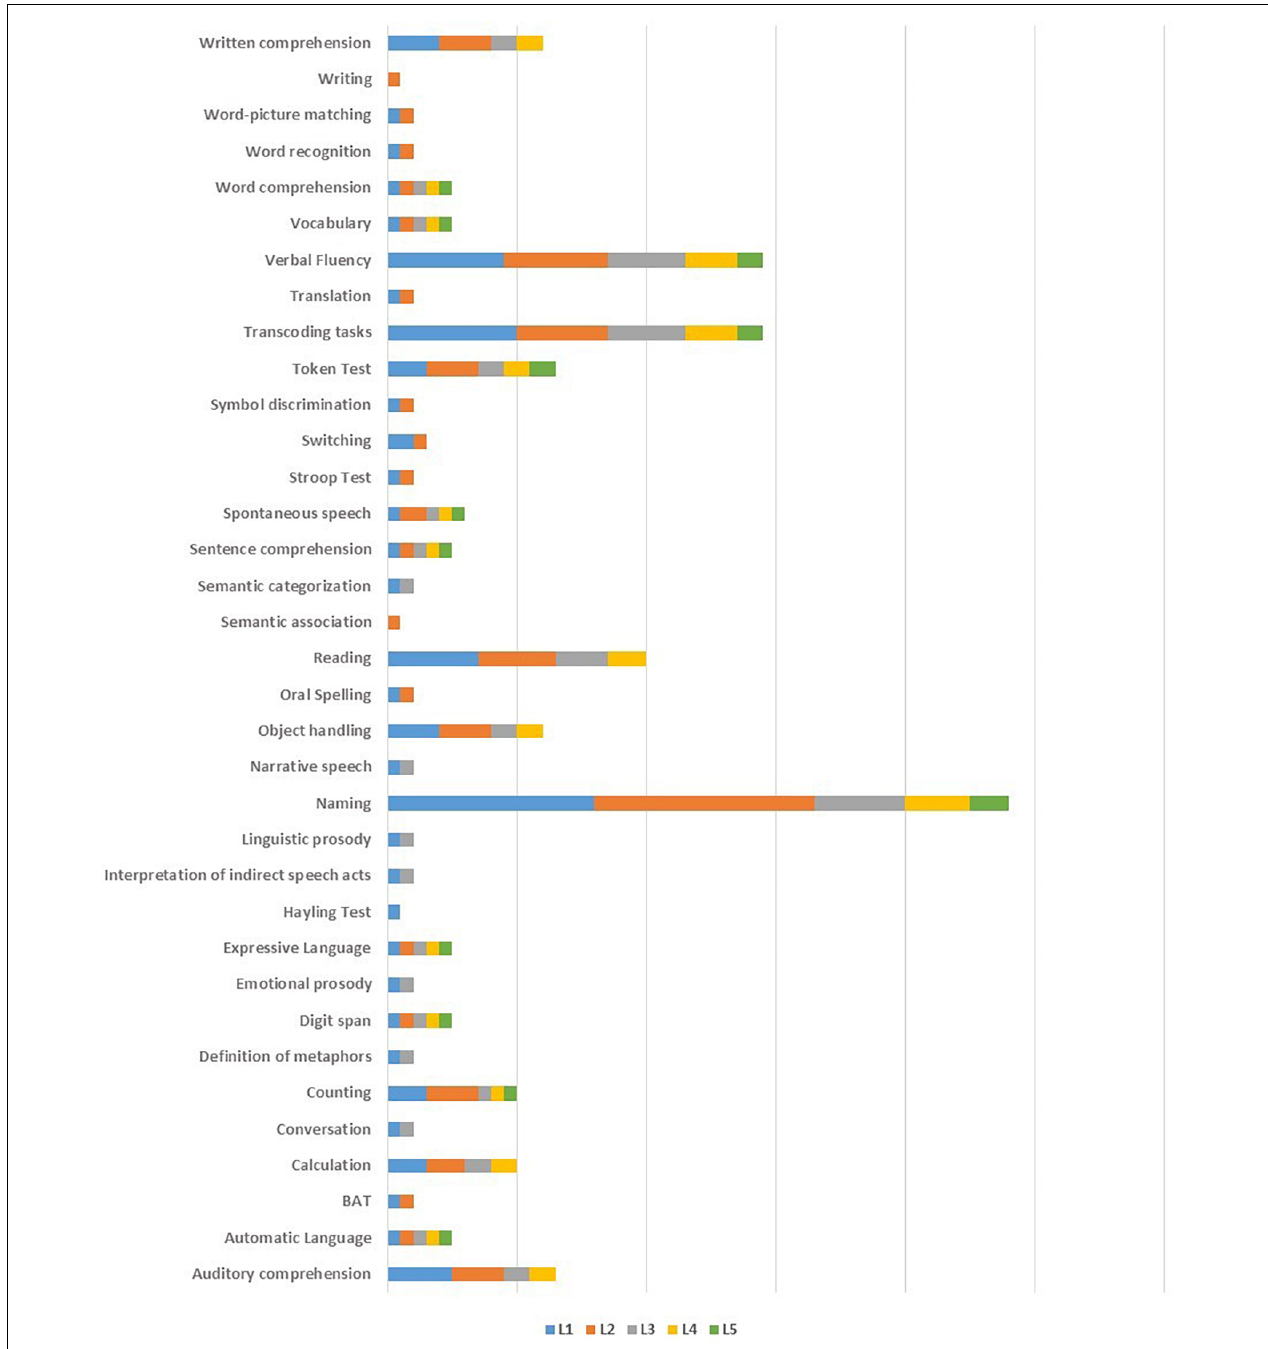
FIGURE 4 | Tests used in preoperative language assessment in each language.